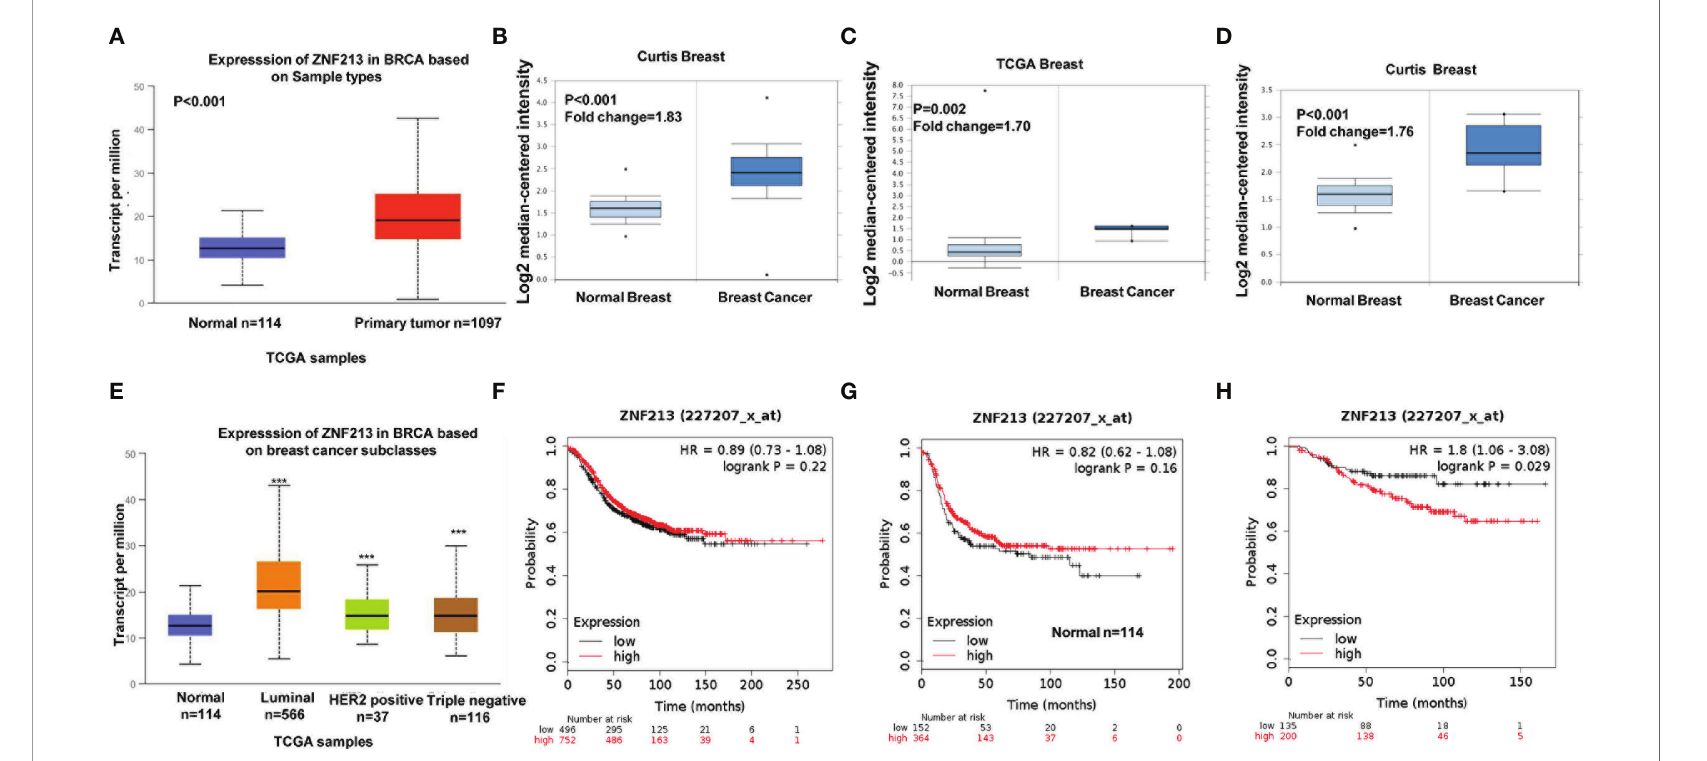
FIGURE 1 | ZNF213 is elevated in human breast cancer and relates to poor prognosis in endocrine therapy patients (A – D) ZNF213 expression is elevated in breast cancer compared with normal breast tissues in multiple database (https://tcga-data.nci.nih.gov/docs/publications/tcga/) and (https://www.oncomine.org/). (E) Comparison of expression levels of ZNF213 in normal tissues and different types of breast cancer tissues in the TCGA database (https://tcga-data.nci.nih.gov/docs/publications/tcga/). ***P < 0.001. (F) ZNF213 has no prognostic impact on ER alpha positive breast cancer. (G) ZNF213 has no prognostic impact on ER alpha negative breast cancer. (H) ZNF213 expression relates to poor prognosis in endocrine therapy